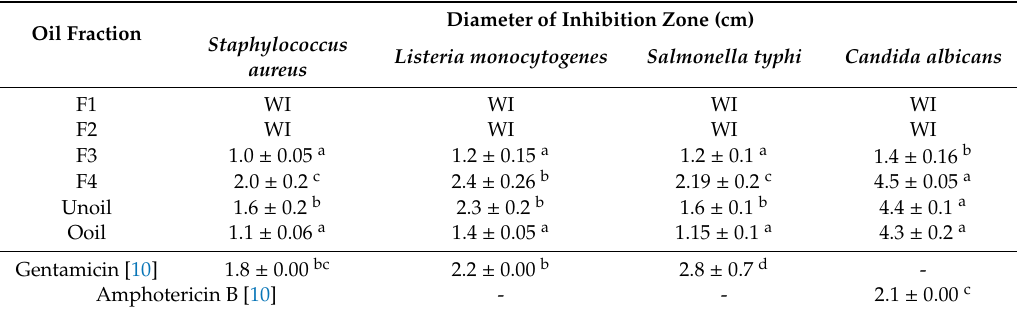
Table 5. Results of disk di ff usion assay. Inhibition zones are given in centimeters